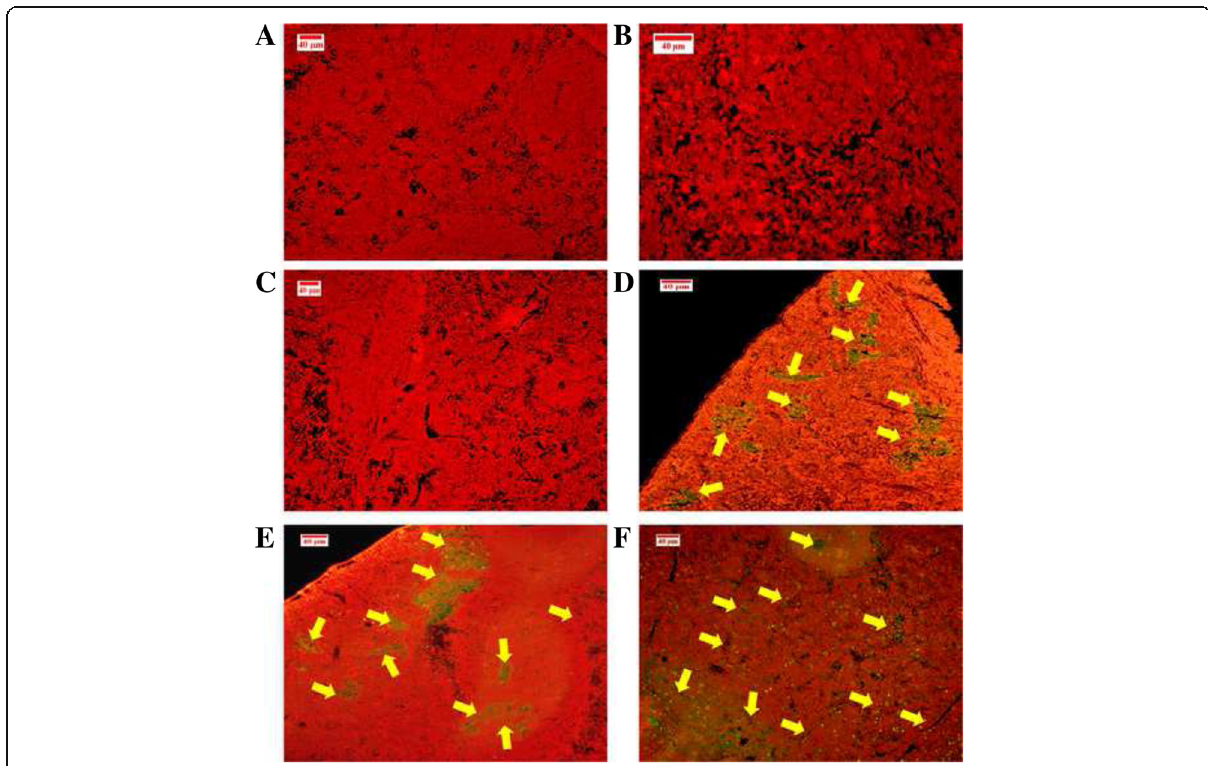
Fig. 14 TUNEL assay used to detect the apoptotic cells in spleen tissues. The yellow arrows point to an apoptotic cell stained green , as shown in the groups treated by BM at 30 mg/kg ( d ), and 60 mg/kg ( e ), and the vinablastine group ( f ). In ( a ) healthy, ( b ) and ( c ) leukaemic groups, no apoptotic cells were